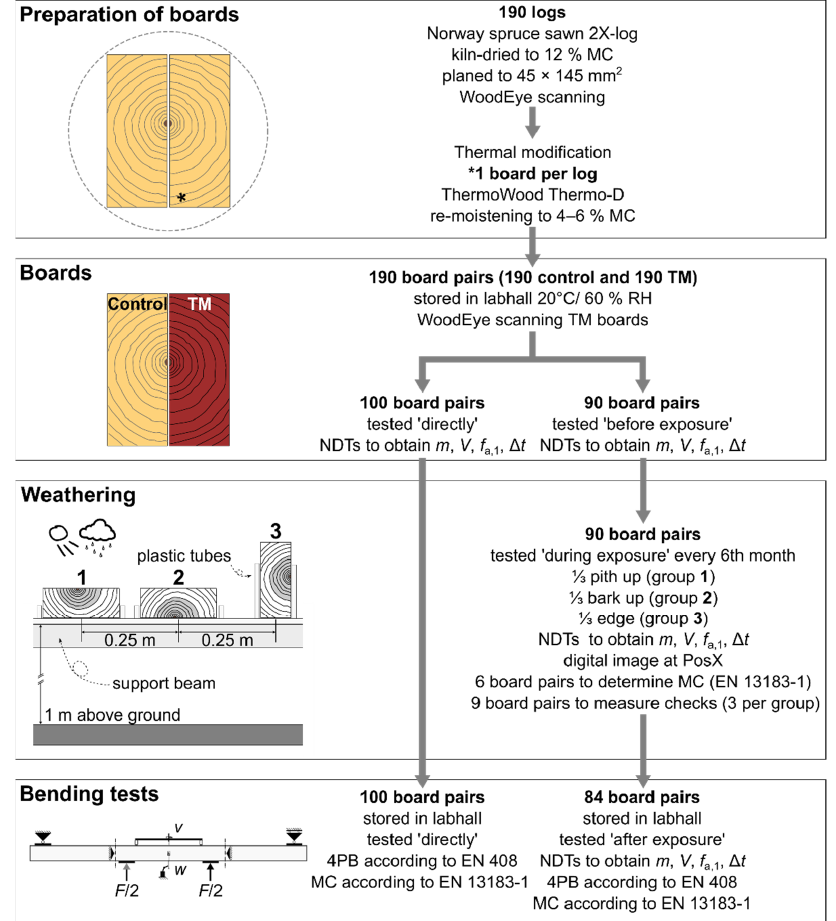
Figure 1. Preparation of boards, and boards used for non-destructive tests (NDTs) and 4-point static bending (4PB)